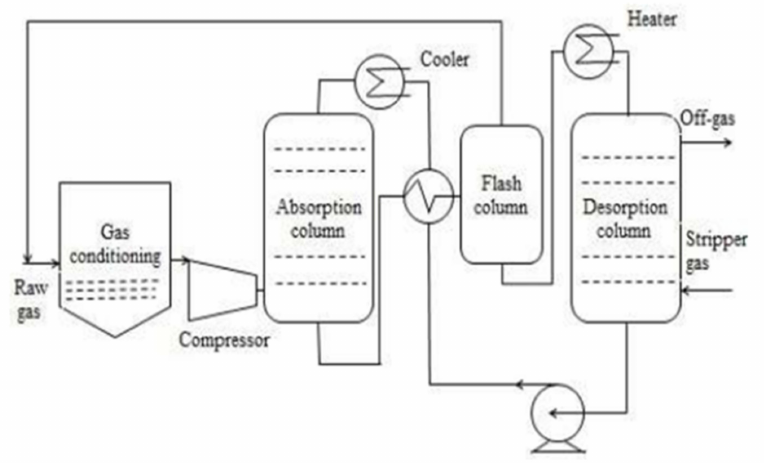
Figure 4. Flow diagram of organic solvent scrubber [31]. Reprinted/adapted with permission from Ref. [31]. Copyright 2022, John Wiley and